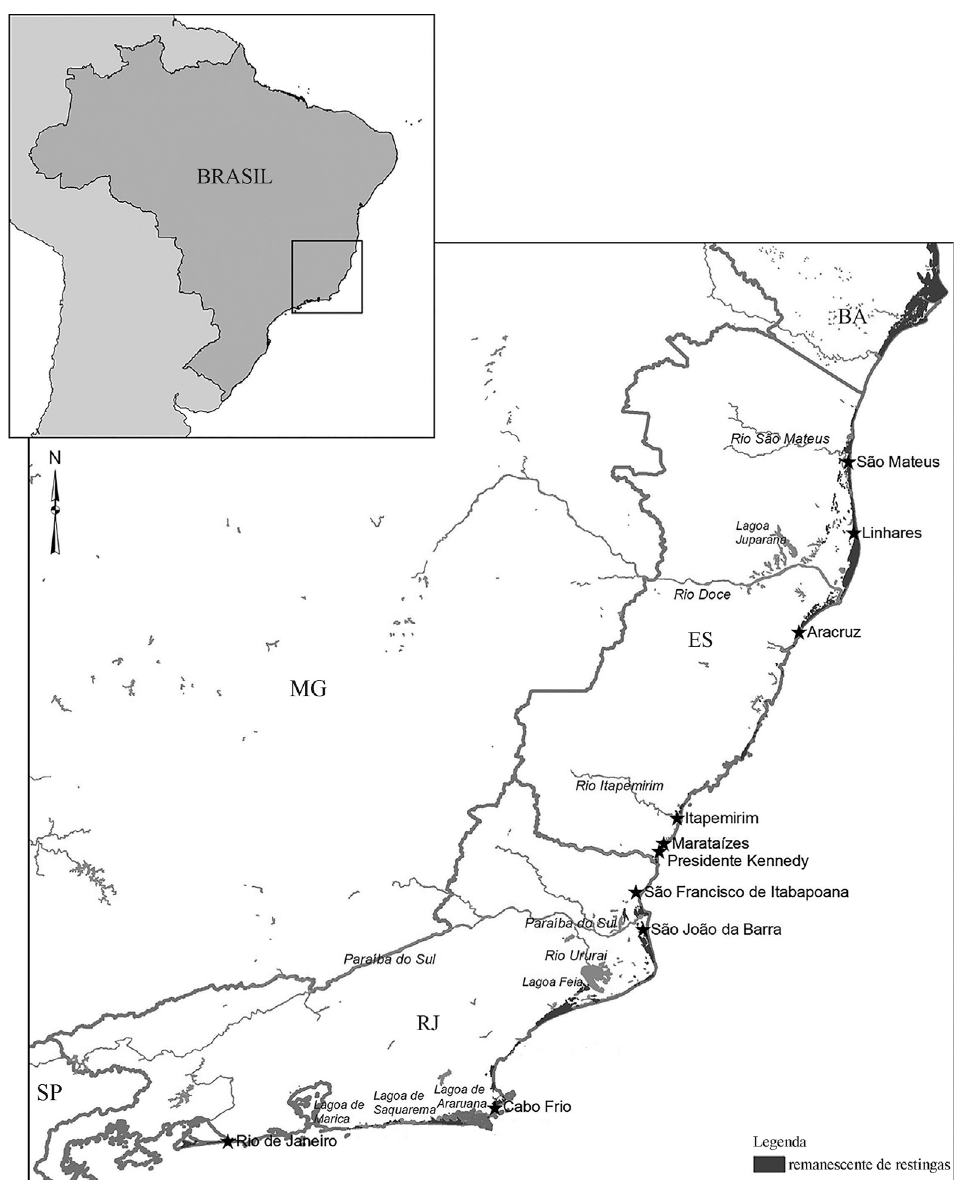
Figure1 - Geographicallocations(*)ofthemunicipalitiesinthestatesofEspíritoSanto(ES)andRiodeJaneiro(RJ)where A.robusta